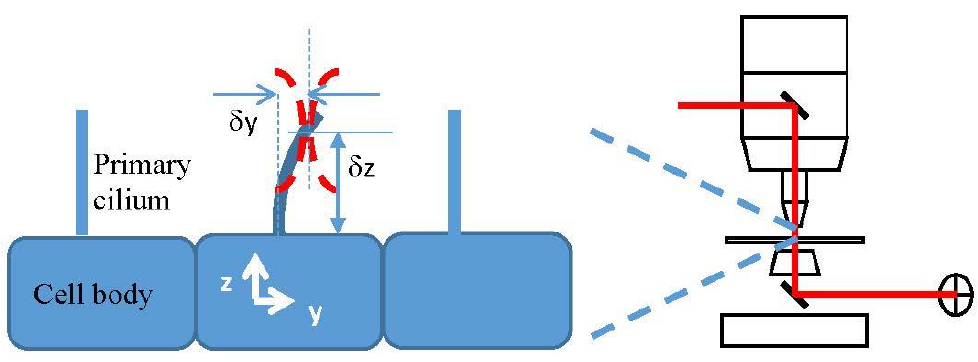
Figure 1. A cilium is trapped with trap displaced from the center of the base by a distance “δy”; the flexible cilium deforms in response to the applied load. The resulting shape is shown when the trap is located at the distal tip of the cilium, but in general is located a distance “δz” from the cell